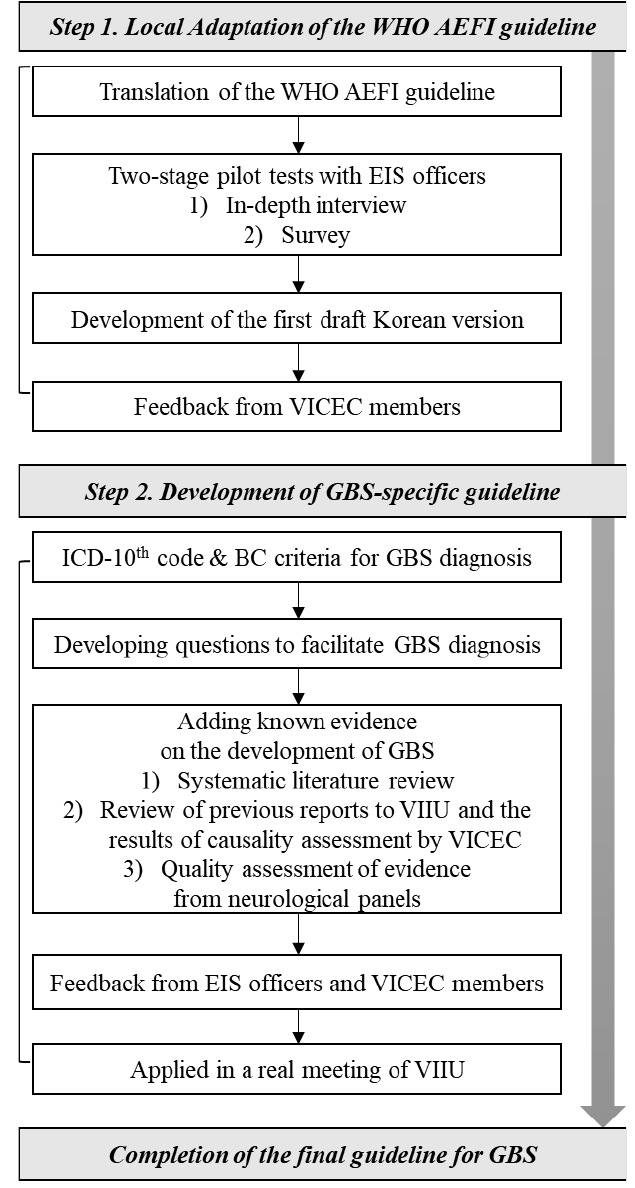
Figure 1. Steps involved in developing a causality assessment guideline for Guillain–Barré syndrome following immunization. (AEFI: Adverse Events Following Immunization; BC: Brighton Collaboration; EIS: Epidemiology Intelligence Service; GBS: Guillain–Barré syndrome; VICEC: Vaccine Injury Compensation Expert Committee; VIIU: Vaccine Injury Investigation Unit).